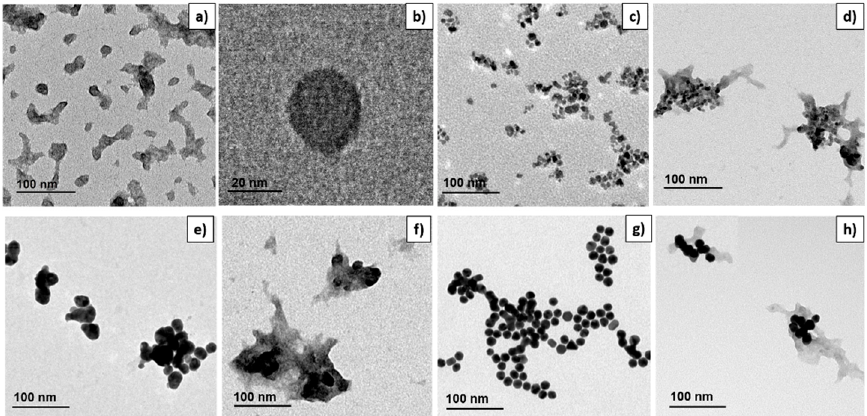
Figure 1. TEM micrographs of ( a ) CS NPs, ( b ) higher magnification of CS NPs, ( c ) Fe 3 O 4 NPs, ( d ) hybrid CS/Fe 3 O 4 NPs, ( e ) Ag NPs, ( f ) hybrid CS/Ag NPs, ( g ) Au NPS and ( h ) hybrid CS/Au NPs. Table 1. Optimization study of ionotropic gelation-based synthesis of CS and CS-based hybrid NPs and their representative characterizations.